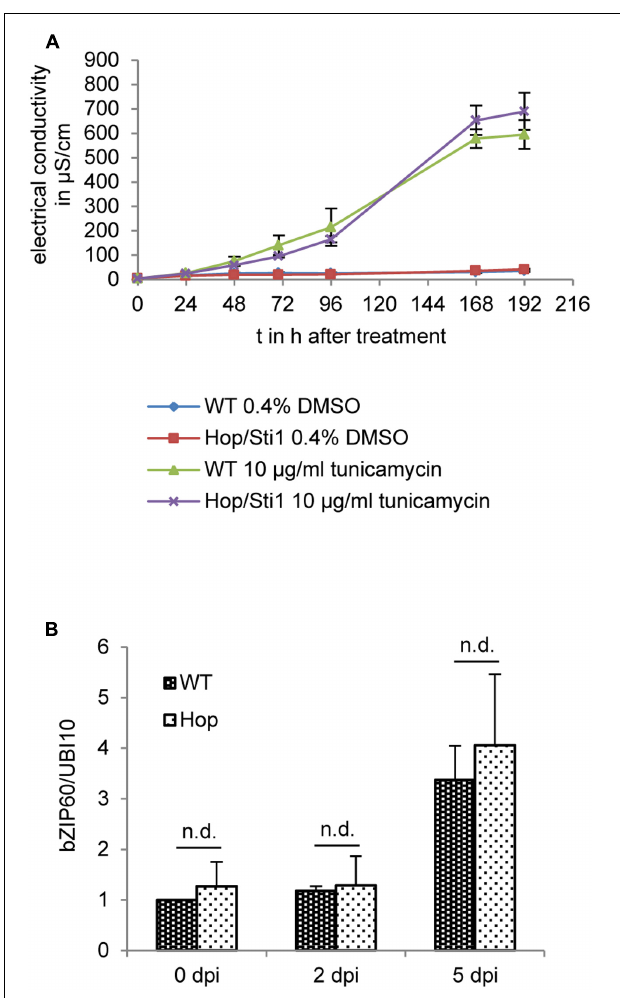
FIGURE 10 | Hop/Sti1-knockdown does not affect the unfolded protein response (UPR) in Nicotiana tabacum leaves. (A) Cell death in response to tunicamycin treatment in wild-type and Hop/Sti1-RNAi plants. Leaf disks were floated on a tunicamycin-solution, ion leakage due to cell death was measured as electrical conductivity of the solution. Error bars represent the standard error. (B) Induction of the UPR by PVY N . Analysis of relative content of spliced bZIP60 by quantitative real-time PCR showed no significant difference (Bonferroni-corrected students t -test, p < 0.05) between wild-type and Hop/Sti1-RNAi plants. Samples were taken from inoculated leaves at the indicated time points. Error bars represent the standard